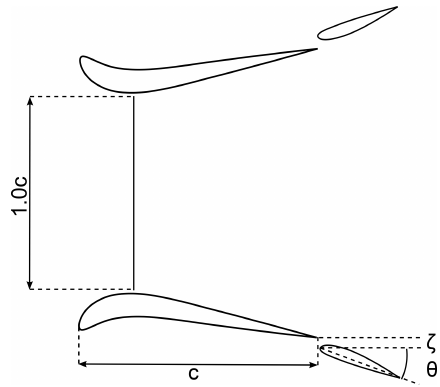
Figure 7. A schematic cross section of the multi-element duct– AD model with the variable flap parameters used for the flap in- stallation study.